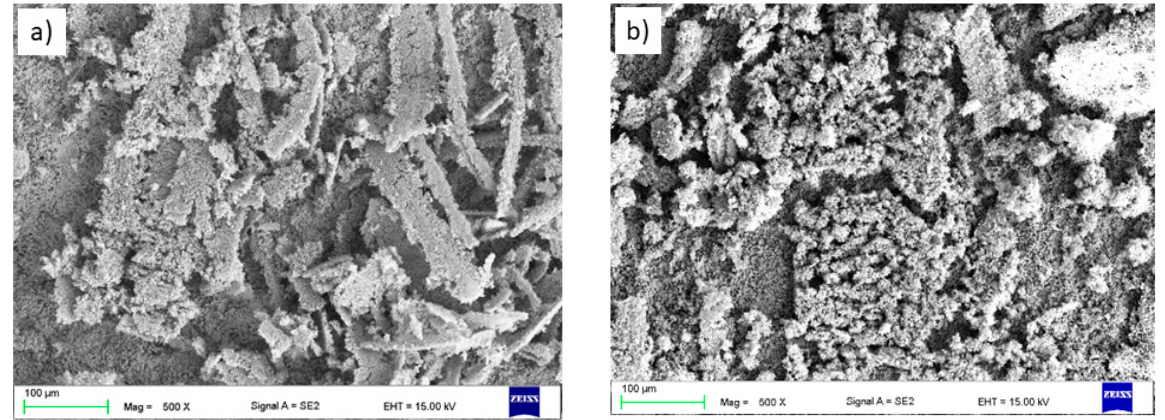
Figure 9. Details of wear tracks of manufactured coatings: ( a , b ) for the WC coating and ( c , d ) for the CrC coating, SEM.